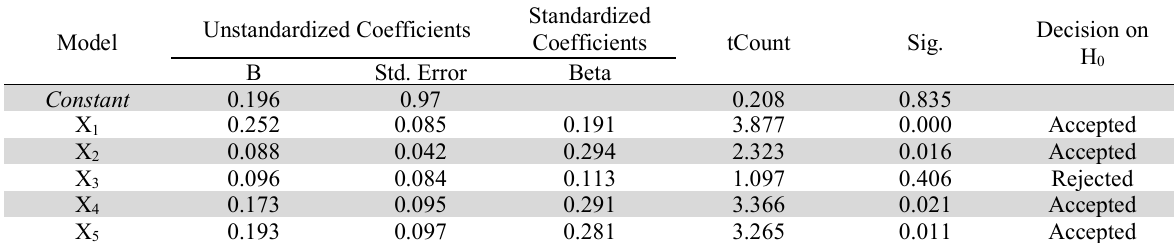
Recapitulation Results of Linear Regression Test and Partial Regression between Tangible